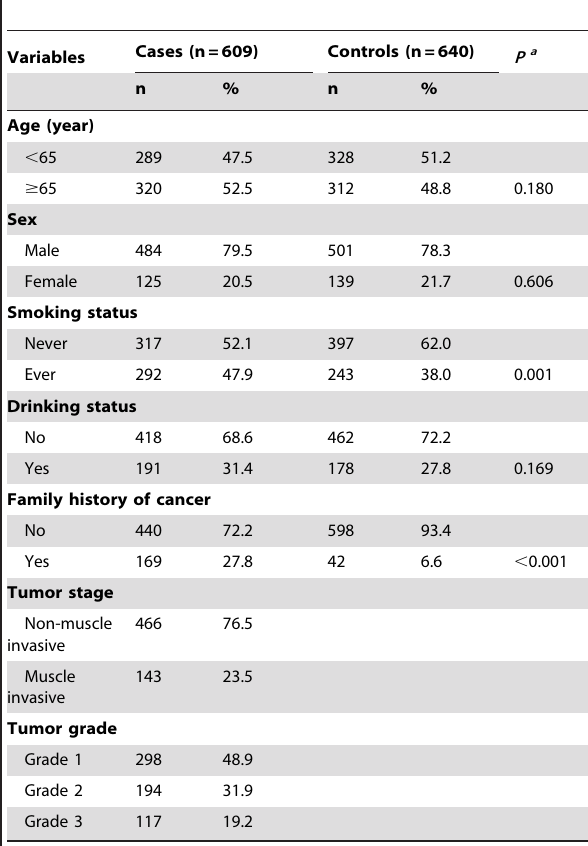
Table 1 . Frequency distribution of selected variables of the bladder cancer cases and